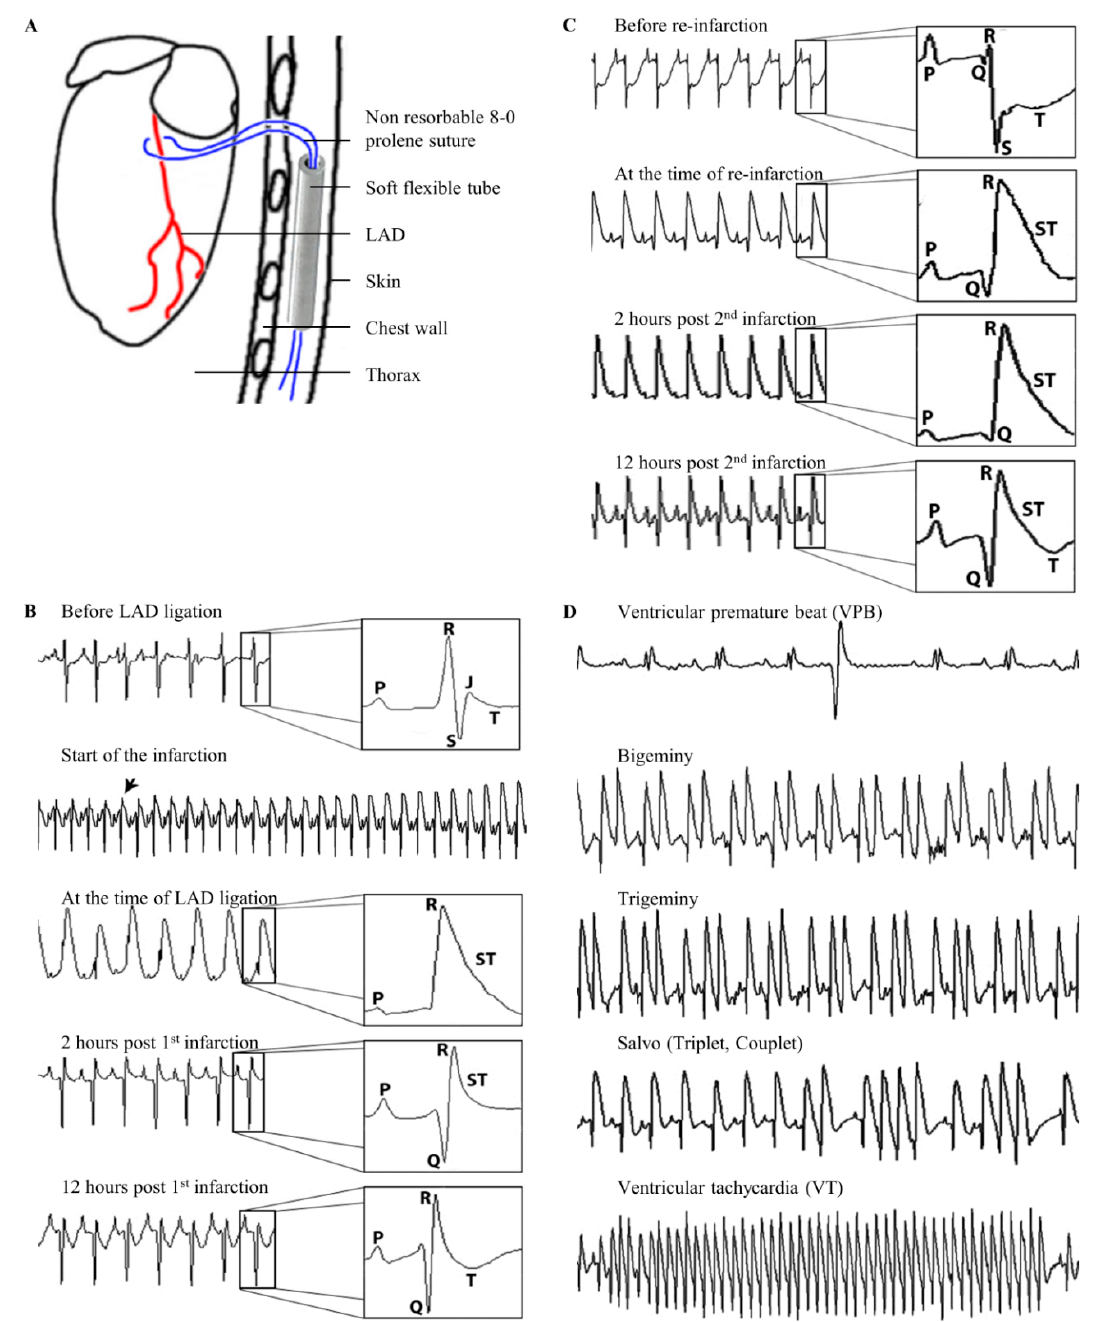
Figure 1. Induction of ventricular arrhythmias (VA). Schematic drawing of the loose left anterior descending (LAD) ligature positioning ( A ). Mouse ECG changes in relation to the time of the firs LAD ligation during ischemia-reperfusion infarction ( B ). Mouse ECG changes in relation to the time of the permanent second LAD-ligation (reinfarction and URI group C ). Mouse ECG strips showing different types of observed VA ( D ).